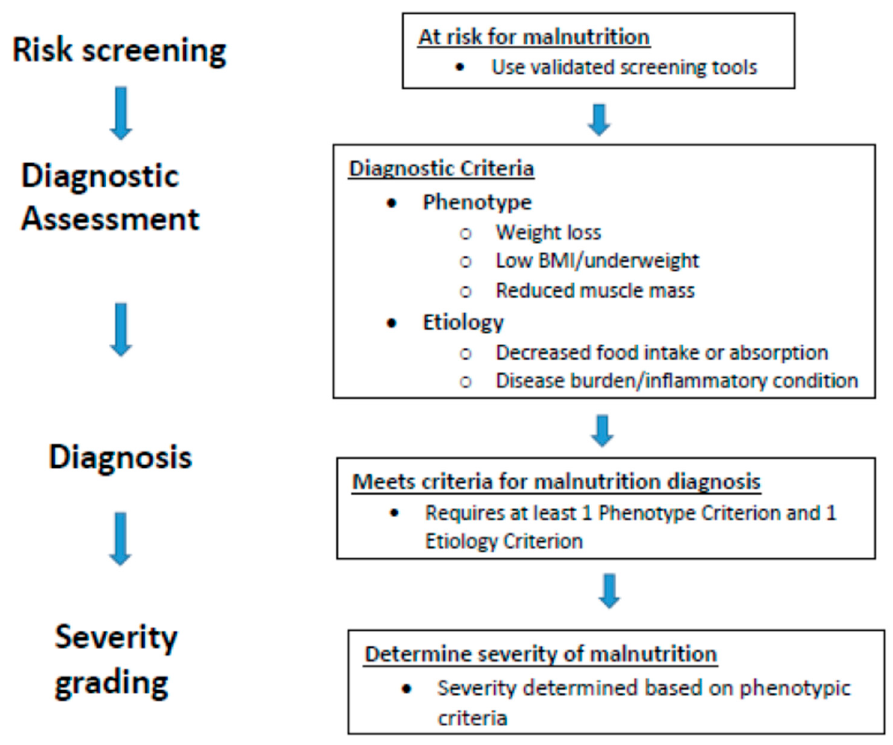
Figure 3. Global Leadership Initiative on Malnutrition (GLIM) diagnostic scheme for screening, assessment, diagnosis, and grading of malnutrition [40].